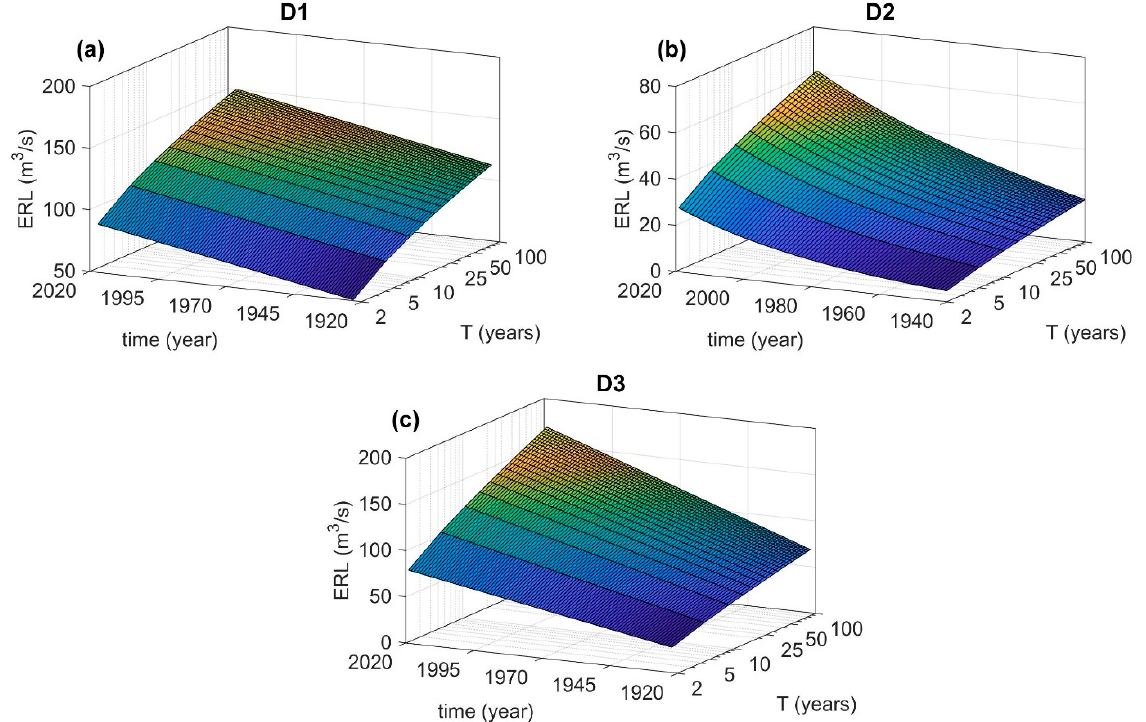
Figure 3. Frequency surfaces for the three datasets, ( a ) D1, ( b ) D2, and ( c ) D3.